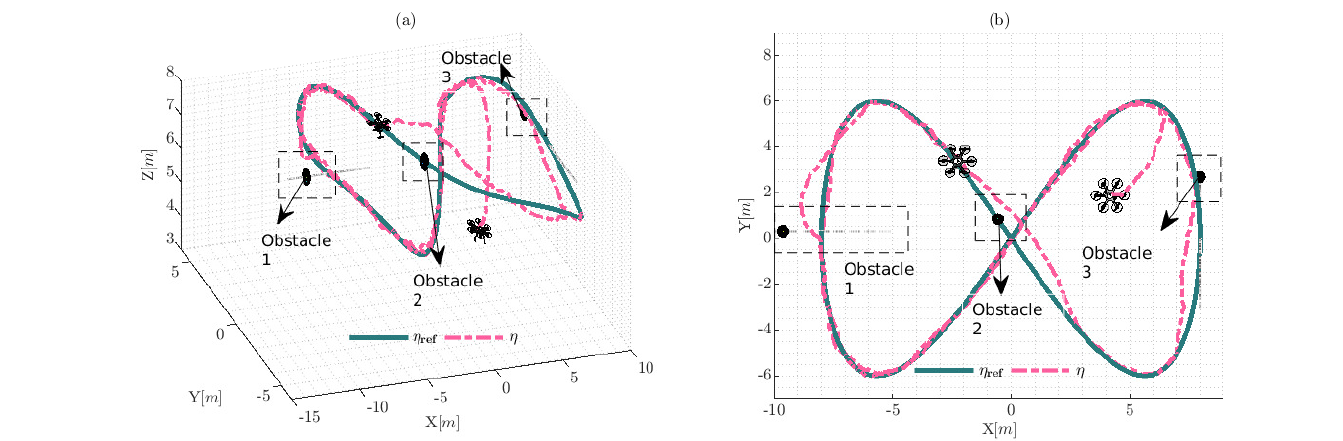
Figure 15. Movements of the hexacopter during the simulation experimentation: ( a ) represents the behavior of the hexacopter platform using the 3D isometric perspective upper view of the experimental information; furthermore, the black spheres represent the static and dynamic obstacles. The velocity of the dynamic obstacles was approximately 0.2cos ( 0.1 t )[ m/s ] over I x for the first obstacle and approximately 0.6cos ( 0.2 t )[ m/s ] over I y for the third obstacle. The second obstacle was considered static and the position is static during the